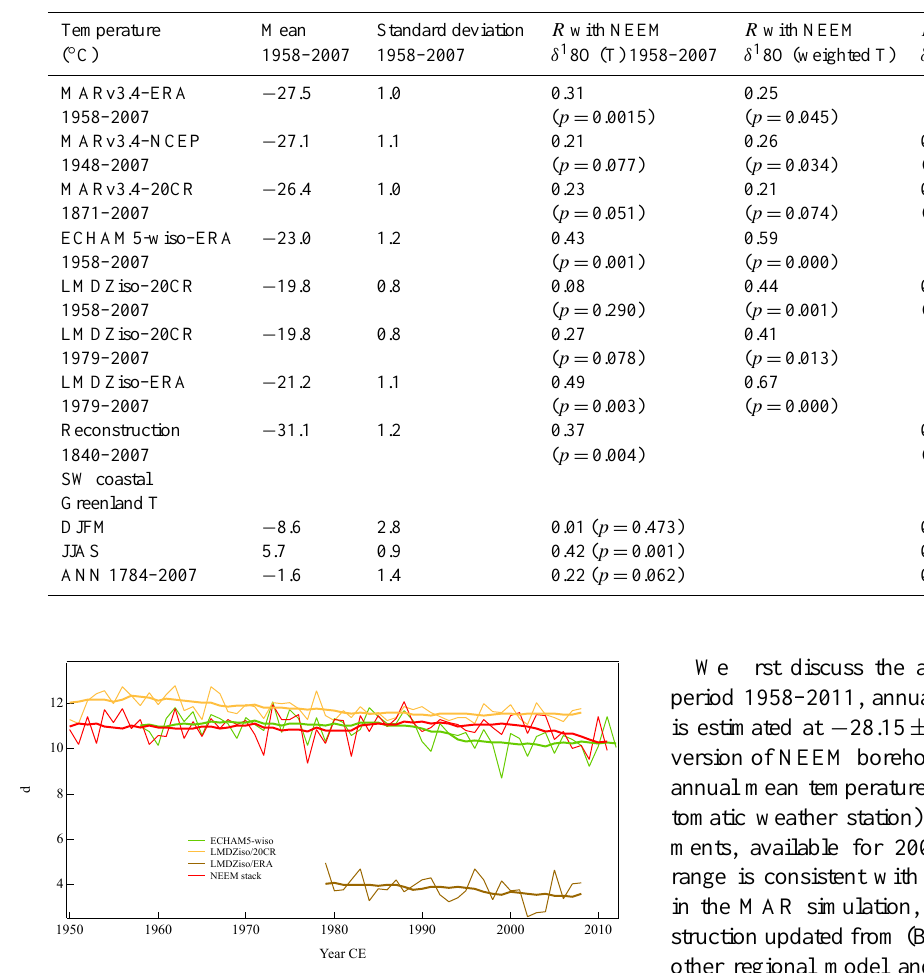
Figure 10. Comparison of NEEM deuterium excess (d, in ‰) with